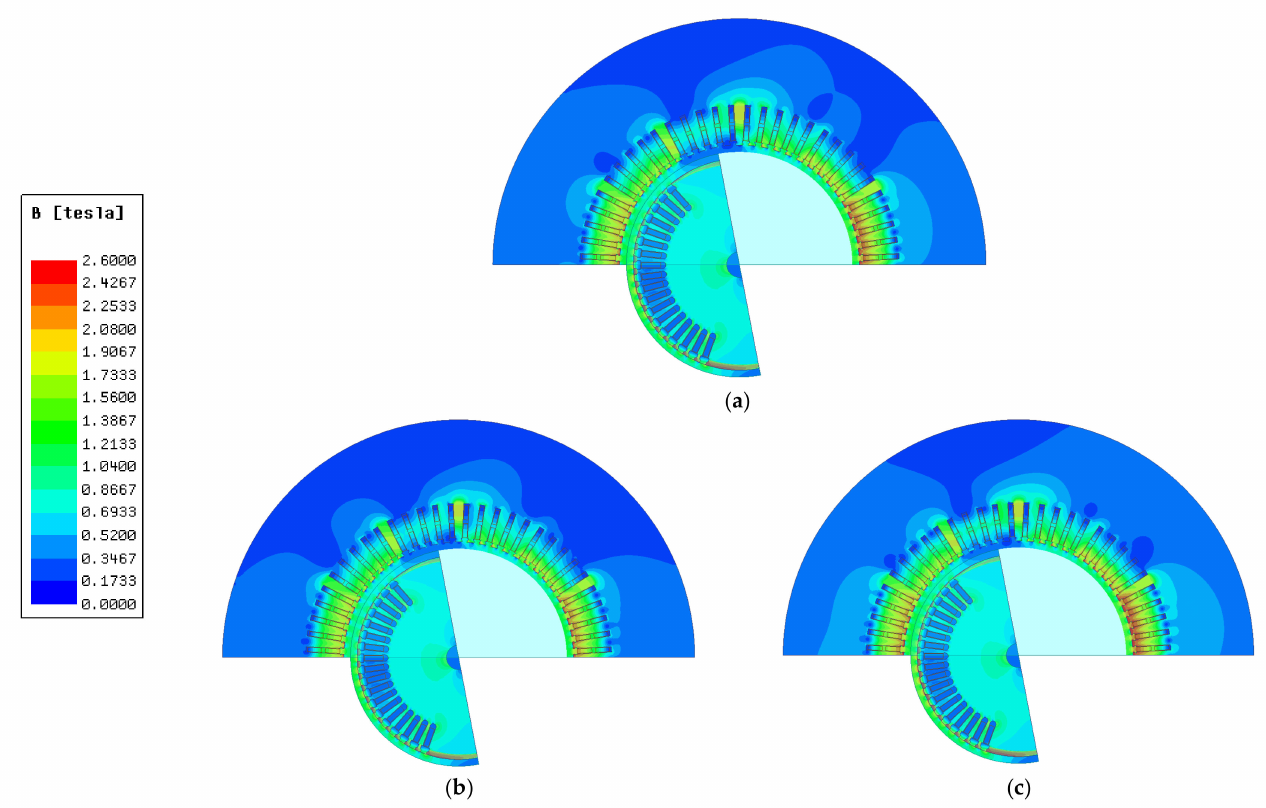
Figure 7. Distributions of magnetic flux density in the cross-section at a three-phase short-circuit for t = 0.01 s for various inductance values of end windings determined: from the 3D model ( a ), acc. to the Abramov formula ( b ), acc. to the Cioc and Nico formula ( c